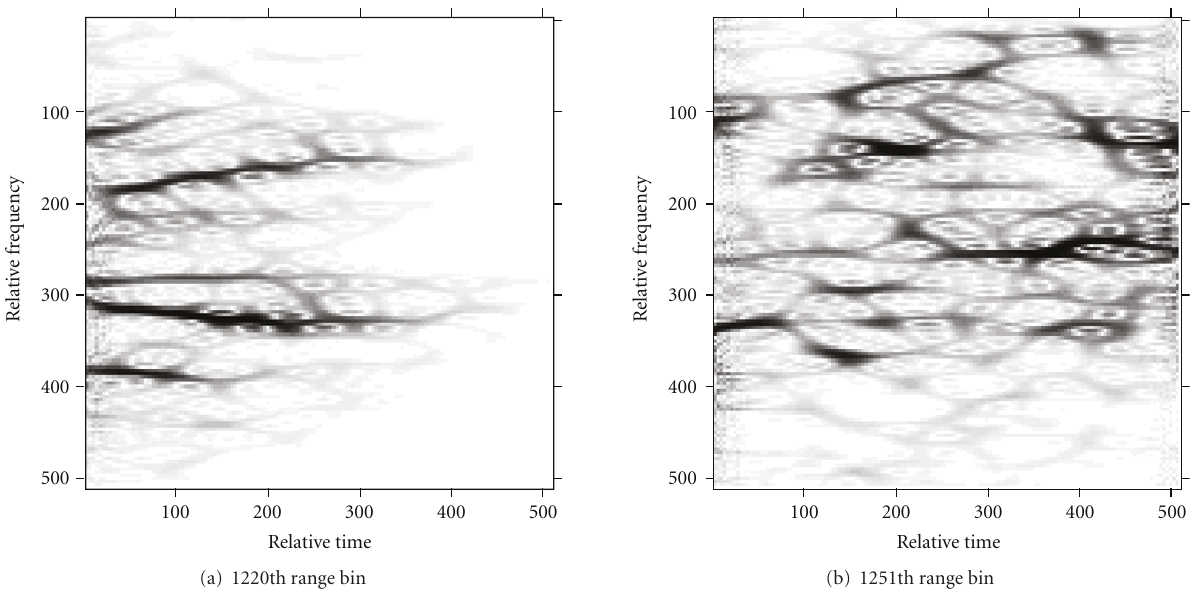
Figure 6: SPWVD of the received signal in a range bin.